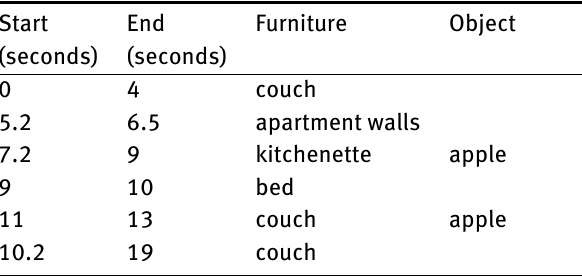
Table 2: The pick a snack scenario: right hand